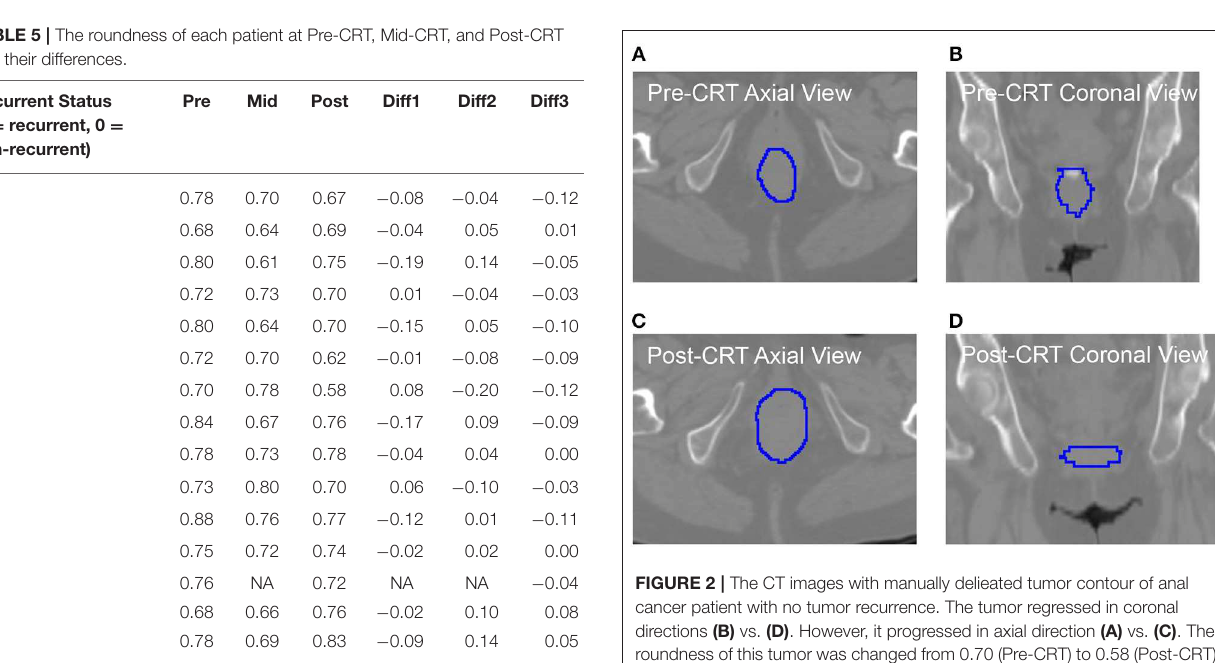
and the naïve Bayesian classifier in this study. By use of these combined features, relatively high performance in the tumor recurrence prediction was achieved (high AUC values) as shown in Tables 3 , 4